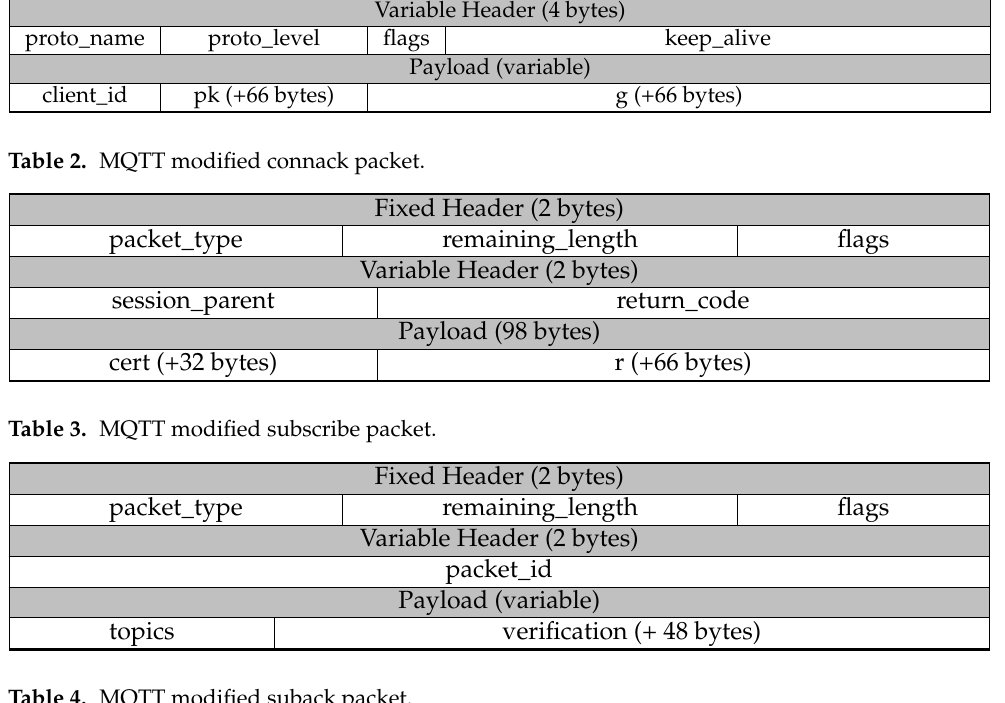
Table 4. MQTT modified suback